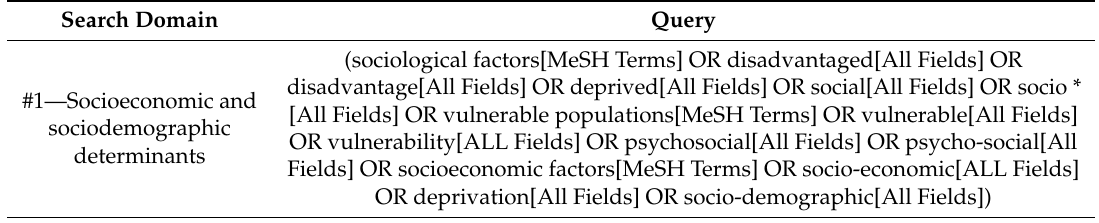
Table 1. Full search strategy executed on PubMed/Medline